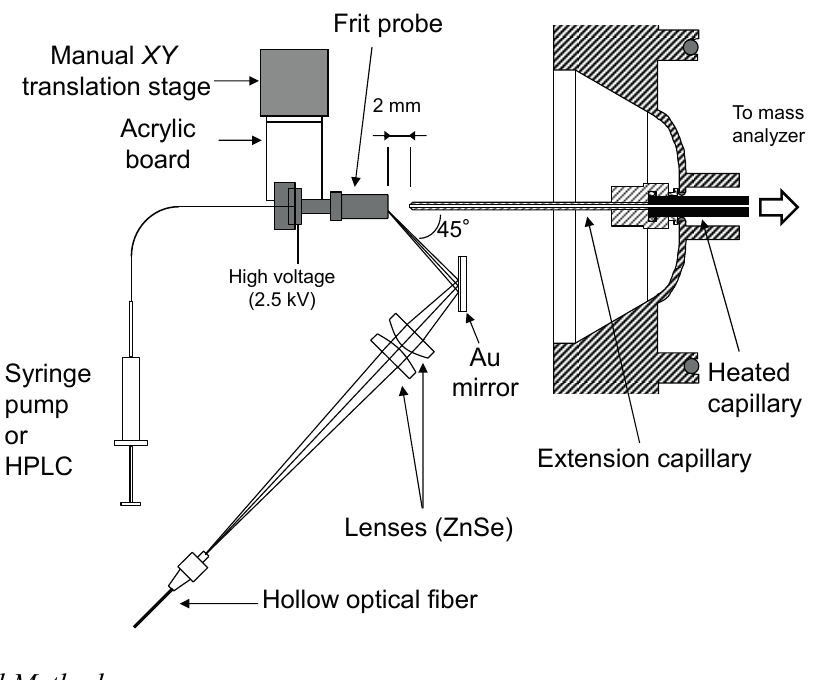
Figure 9. Schematic of the ion source for continuous flow atmospheric pressure laser/desorption ionization using a frit probe integrated with the ion trap mass